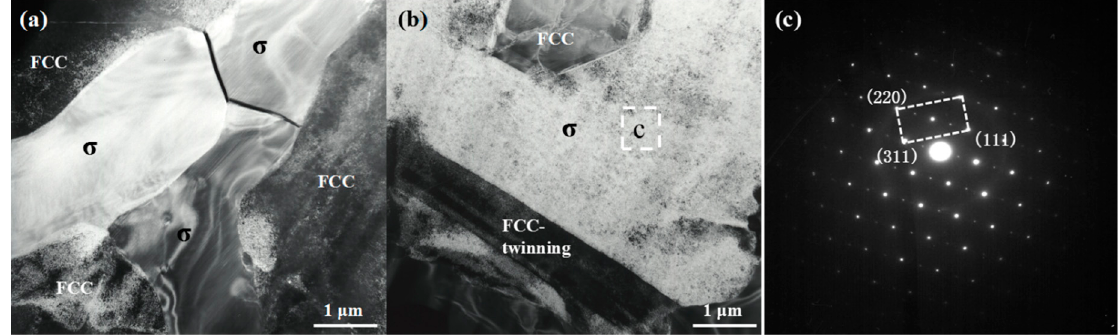
Figure 6. Transmission electron microscopy (TEM) image ( a ), ( b ) of the marked area in Figure 3a of FeCoCrNiMo HEA after sintering at 1150 °C and 30 MPa, and the selected-area diffraction (SAED) pattern ( c ) of the marked area in ( b ).